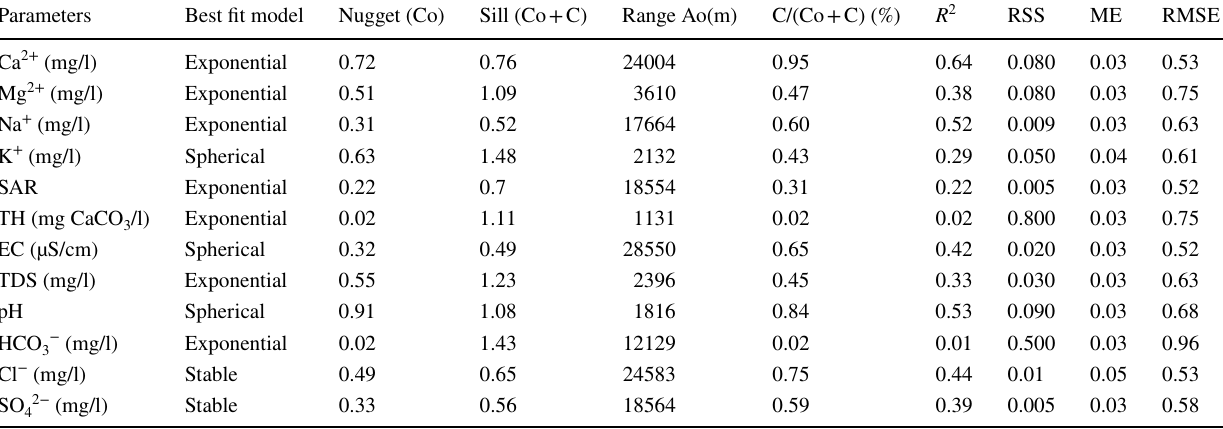
Table 4 Best fit model summary of semivariogram analysis for groundwater quality parameters